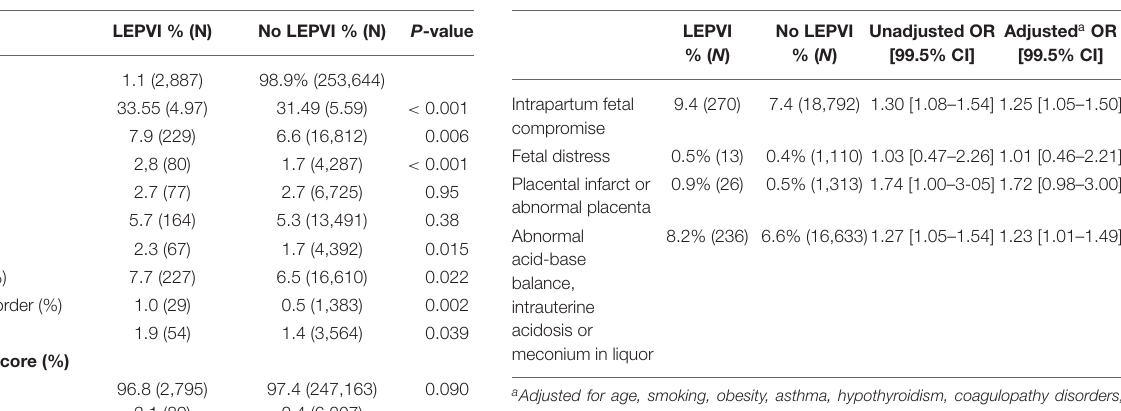
TABLE 1 | Descriptive statistics for selected characteristics for pregnant women with and without LEPVI, Spain 2015.